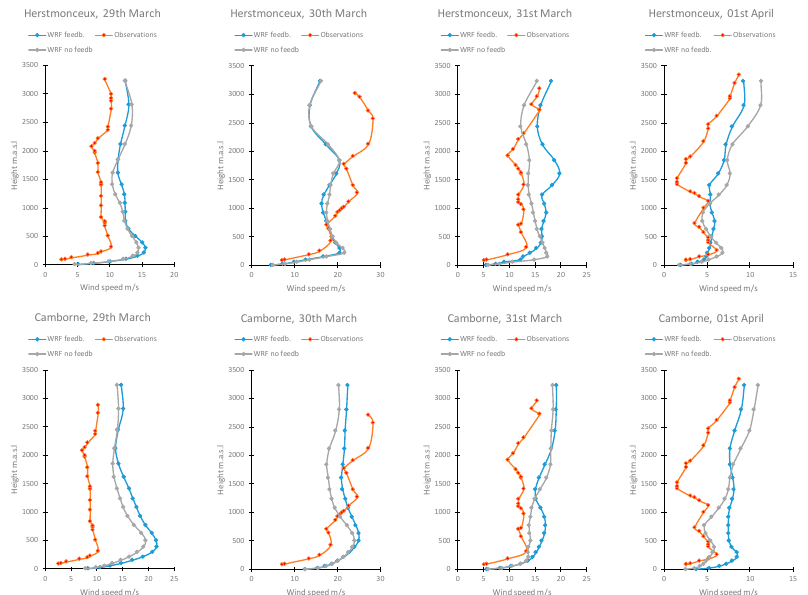
Figure 2. Observed vertical profile of wind speed (red line) from the two atmospheric sounding sites and calculated vertical profile of wind speed in the WRF model (domain03) with (blue line) and without (grey line) radiative feedback. The upper panel corresponds to the Herstmonceux site, the lower panel—to the Camborne site.